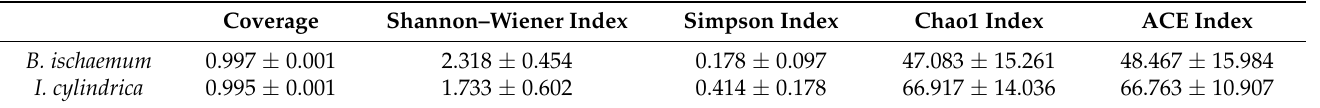
Table 2. Diversity index results of protozoan communities in plant litter.